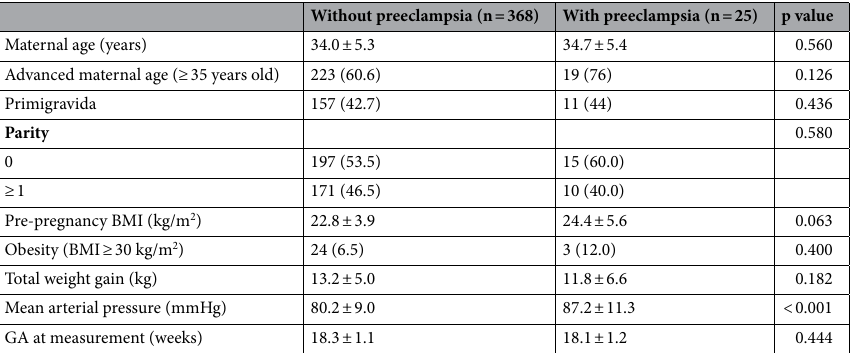
Table 1. Baseline characteristics of women with and without preeclampsia. Data are presented as the mean ± SD or as N (%). GA gestational age, BMI body mass